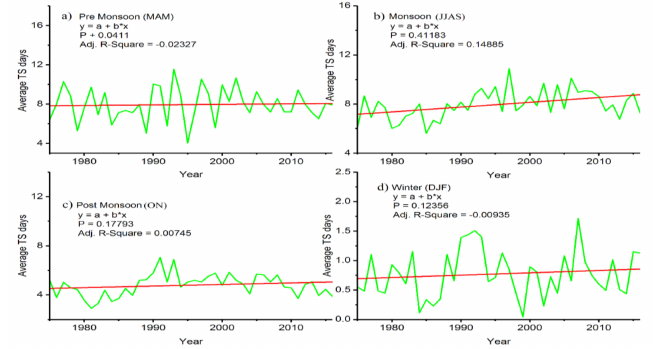
Figure 3. Seasonal variation days ( a ) premonsoon (March–May (MAM)); ( b ) monsoon (June–September (JJAS)); ( c ) postmonsoon (October–November (ON)); ( d ) winter (December–February(DJF)) of TS days in Bangladesh during